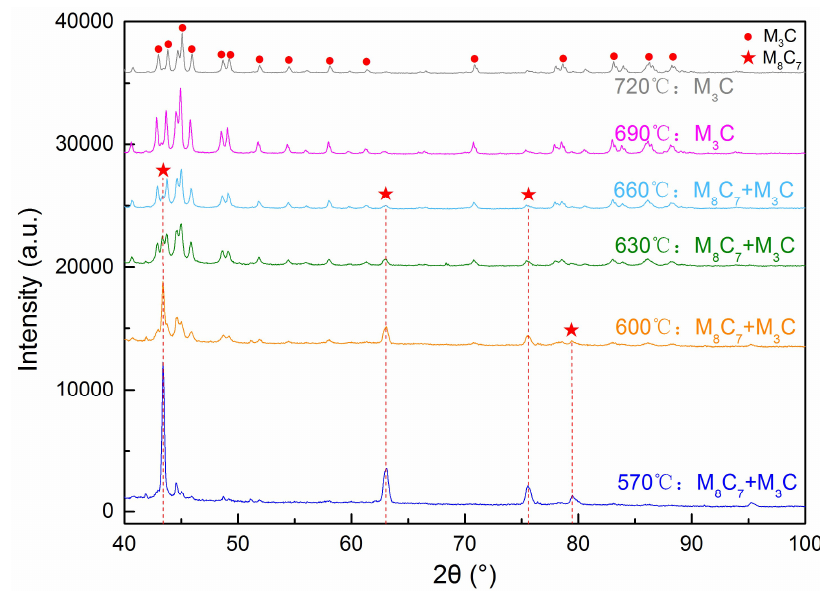
Figure 3. XRD spectra of carbides in 42CrMo4-V steel tempered at 570–720 °C